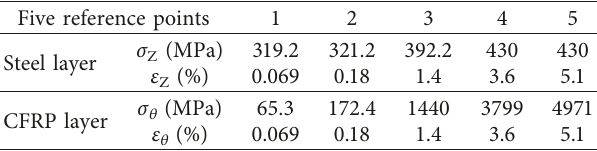
Table 2: Numerical stresses and strains for each